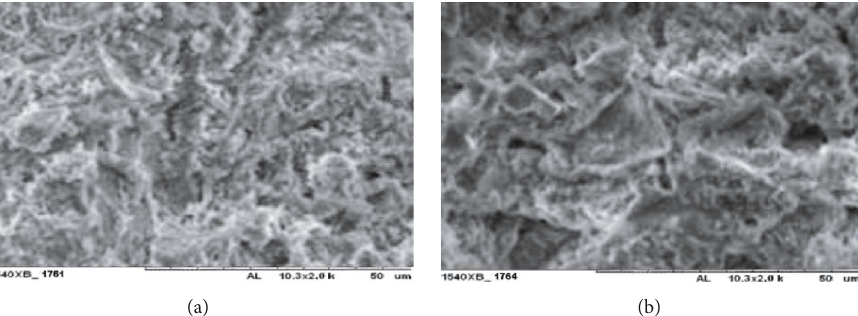
Figure 7: The cement stone microstructure: (a) CEM I 42.5N based; (b) composite binder based (composition number 7 in Table 5).